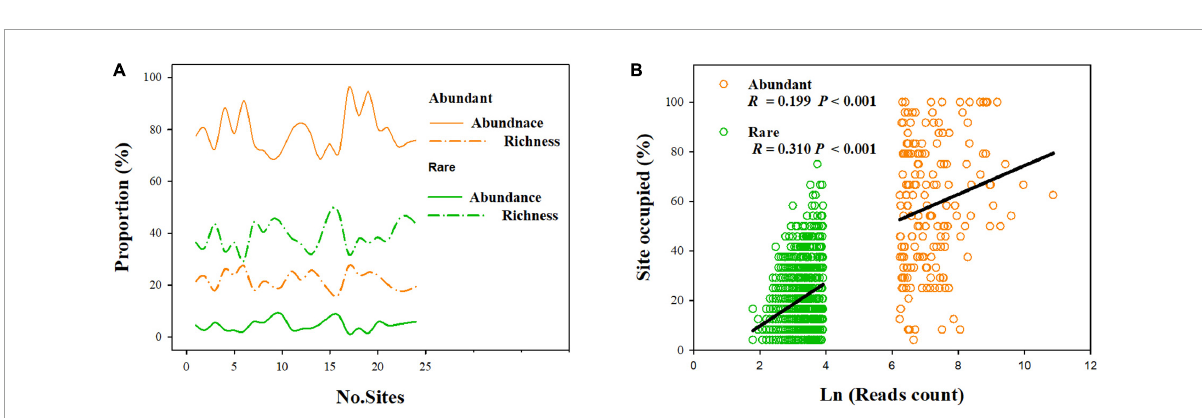
FIGURE2 Distributions of rare and abundant fungi in desert soils. (A) The proportion of the OTUs’ richness (“richness”) and relative abundance of abundant and rare fungi compared to the whole fungal community in each sample. (B) Abundance–occupancy relationships for the abundant and rare